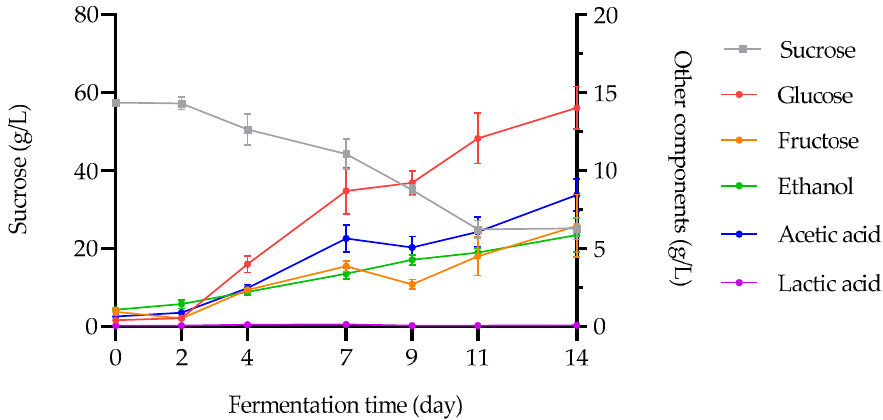
Figure 2. Evolution of the concentration of carbohydrates, alcohol, and acids (g/L) as functions of fermentation time (day) at 30 °C (mean ± SD; n = 3).